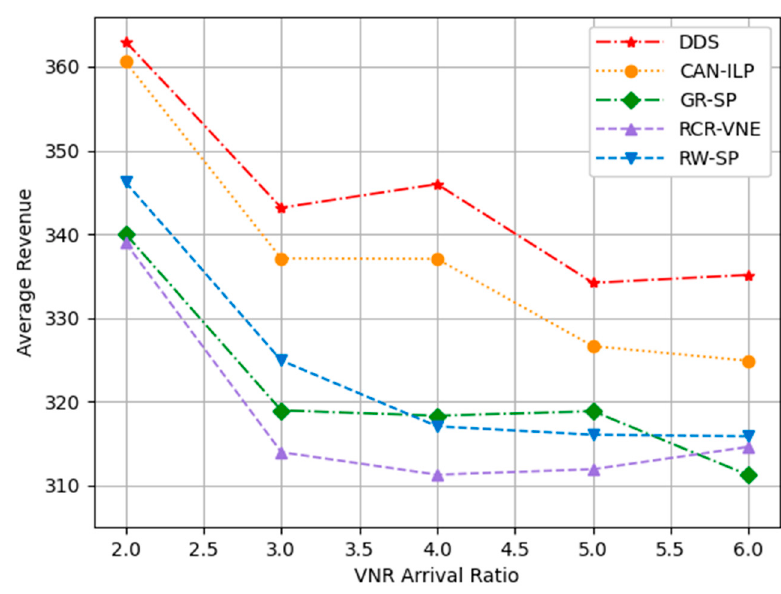
Figure 5. Average revenue under various VNR arrival ratios.